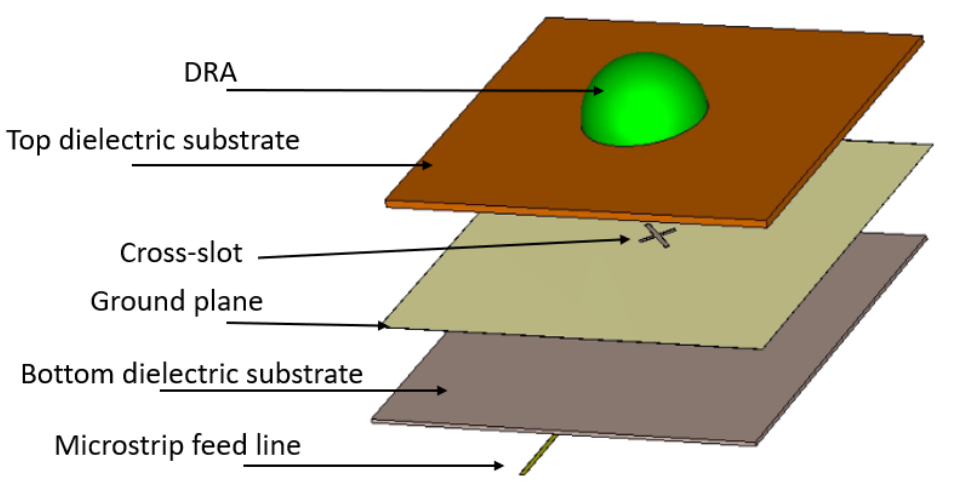
Figure 5. 3D view of the proposed configuration using additional substrate with the same feed network.